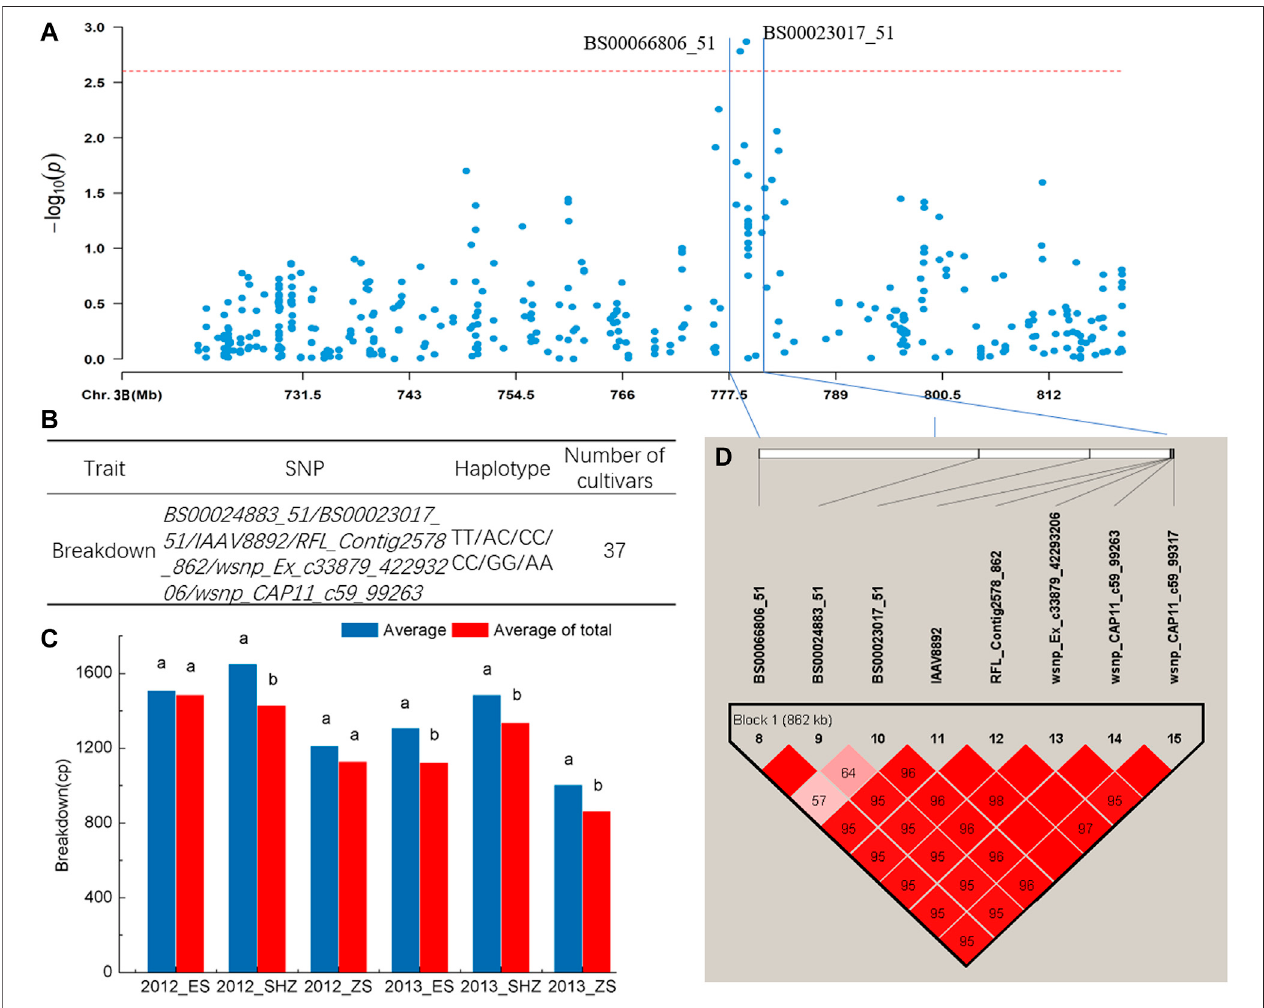
FIGURE 3 | Haplotype analysis. (A) Local Manhattan plot. (B) Haplotypes with different SNP alleles in the block. (C) Phenotypic effects of haplotypes in different environments, Different lowercase letters indicate signi fi cant differences at p < 0.05. (D) Haplotype analysis of multi-environment signi fi cant SNPs associated with breakdown on chromosome 3B, the color represents the linkage between SNPs, and the deeper color means the higher linkage between